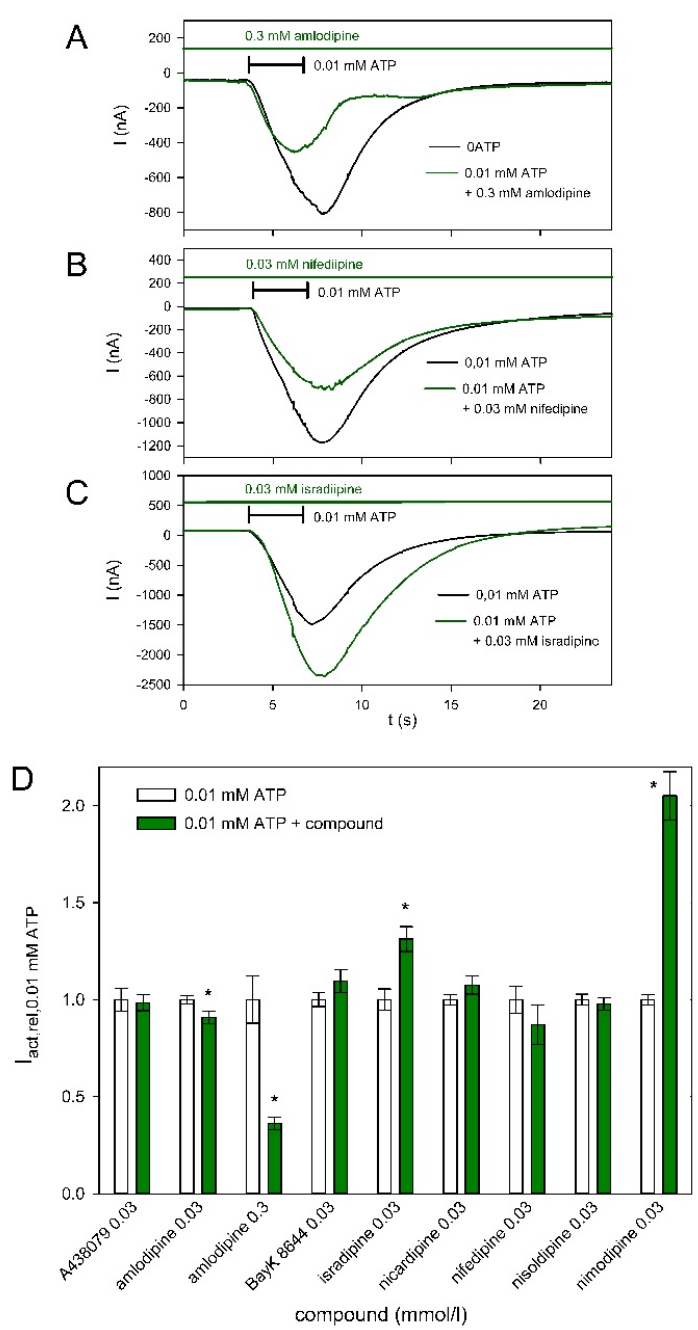
Figure 5. Effect of different dihydropyridines and the P2X7-specific blocker A438079 on hP2X5 FL - mediated currents. Examples of the inhibitory effect of amlodipine ( A ) the effect of nifedipine ( B ) and the stimulatory effect of isradipine ( C ) on ATP-induced currents. Currents were evoked by ATP in bathing solution and 2 min later in bathing solution supplemented with the indicated dihydropyridine derivative. ( D ) Summary of the effects of A438079 and various dihydropyridines on ATP-induced currents. Means are normalized to the mean value of the currents measured during the second ATP application without additional substances (control). Means of 9–50 oocytes. Values that differ significantly from the ATP-only control are marked by asterisks.